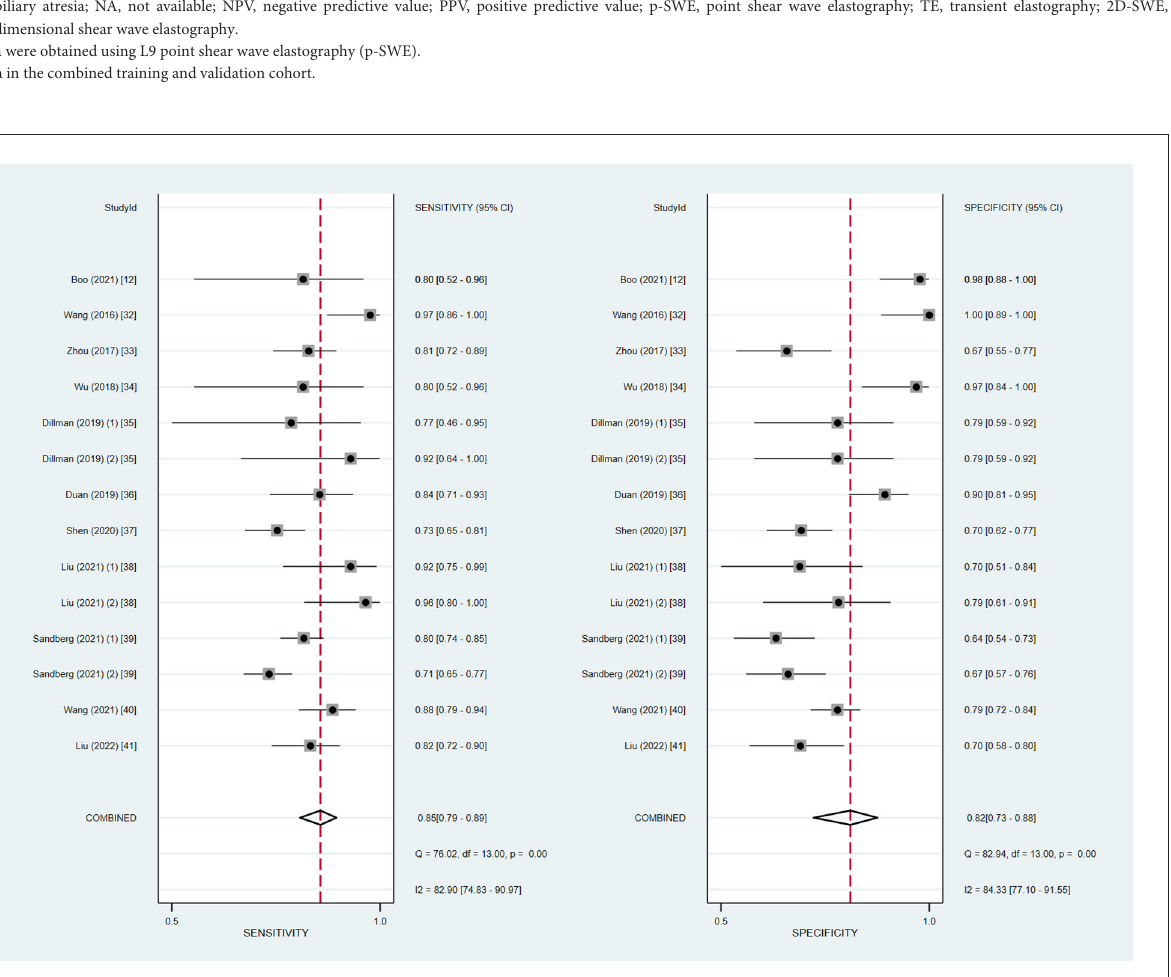
FIGURE2 Coupled forest plots of the summary sensitivity and specificity of ultrasound elastography for the diagnosis of biliary atresia